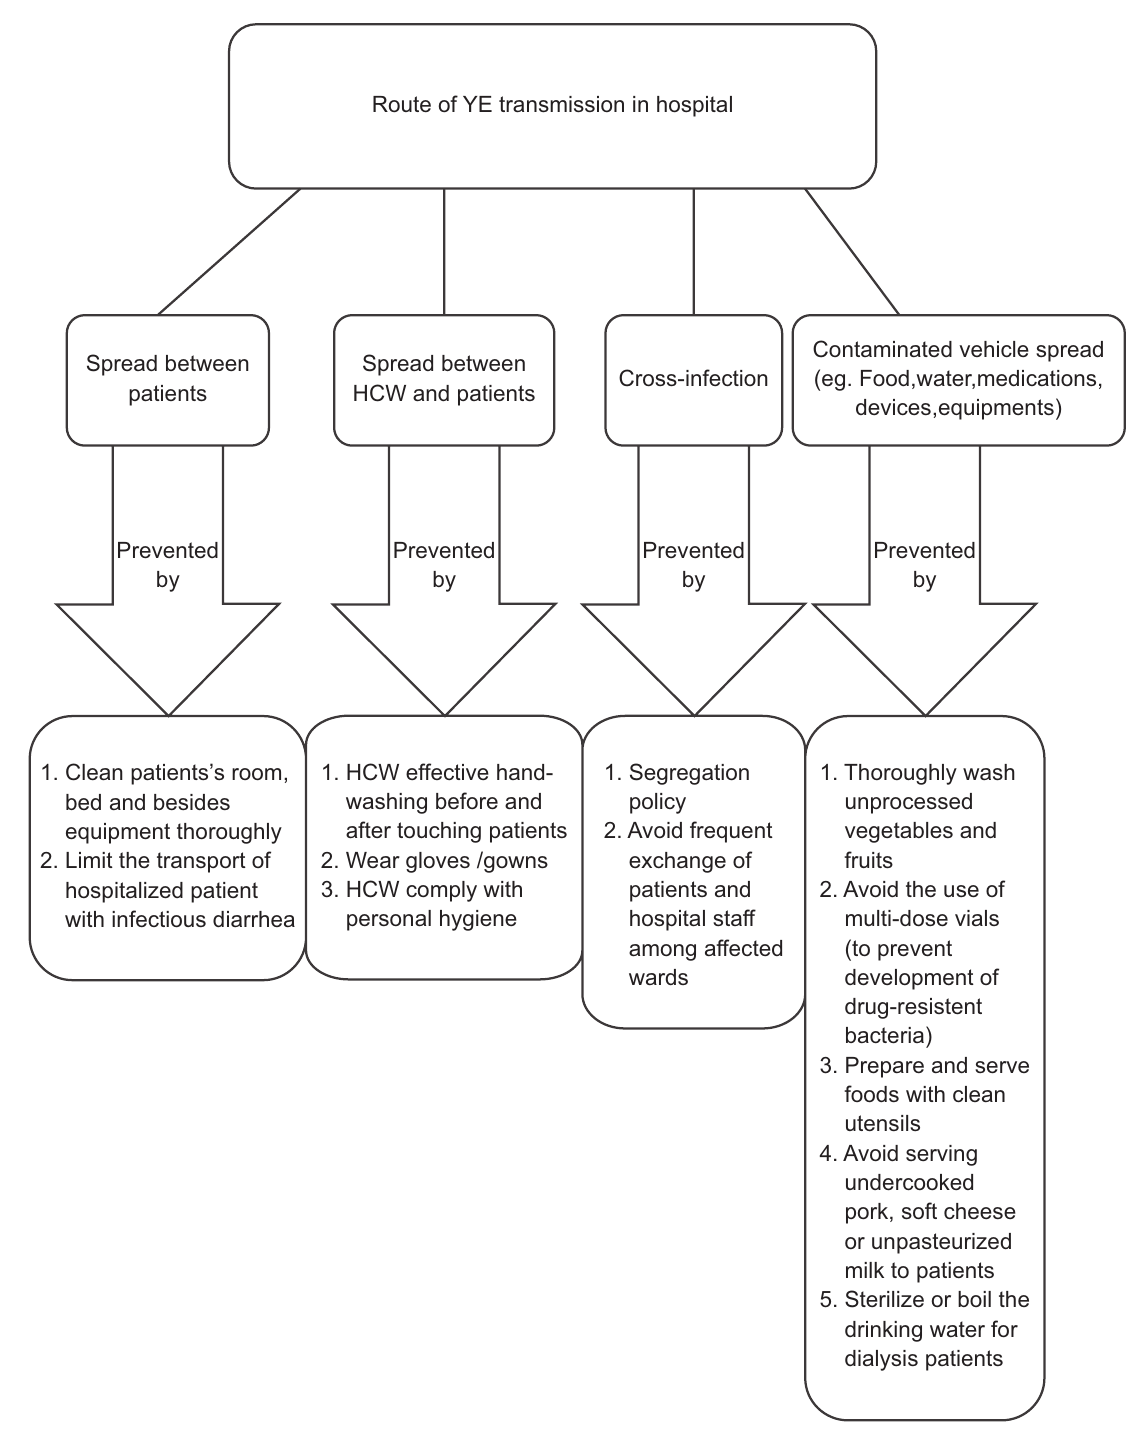
Figure 1: The nosocomial transmission routes and prevention of Yersinia enterocolitica infection in dialysis units. YE: Yersinia Enterocolitica; HCW: healthcare